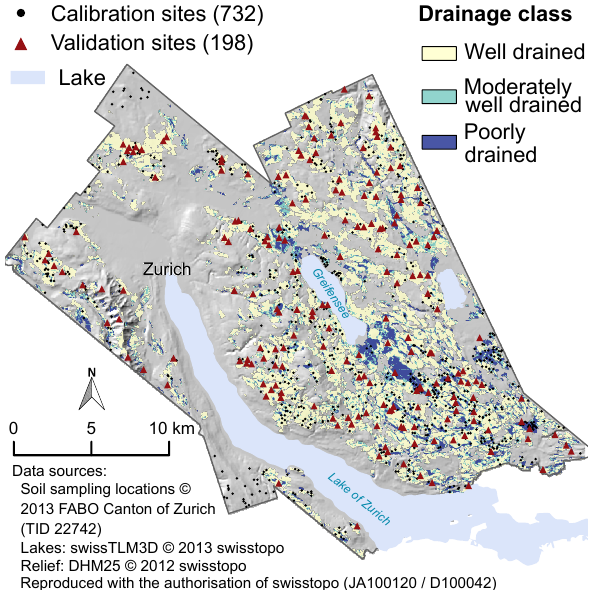
Figure 7. The geoGAM predictions of drainage classes for the agricultural land in the Greifensee study region (computed on a 20m grid with final geoGAM, with covariates according to Table 2, smoothed for better display with focal mean with radius of 3 pix- els = 60m). Black dots are locations used for geoGAM calibration, and locations with red triangles were used for model